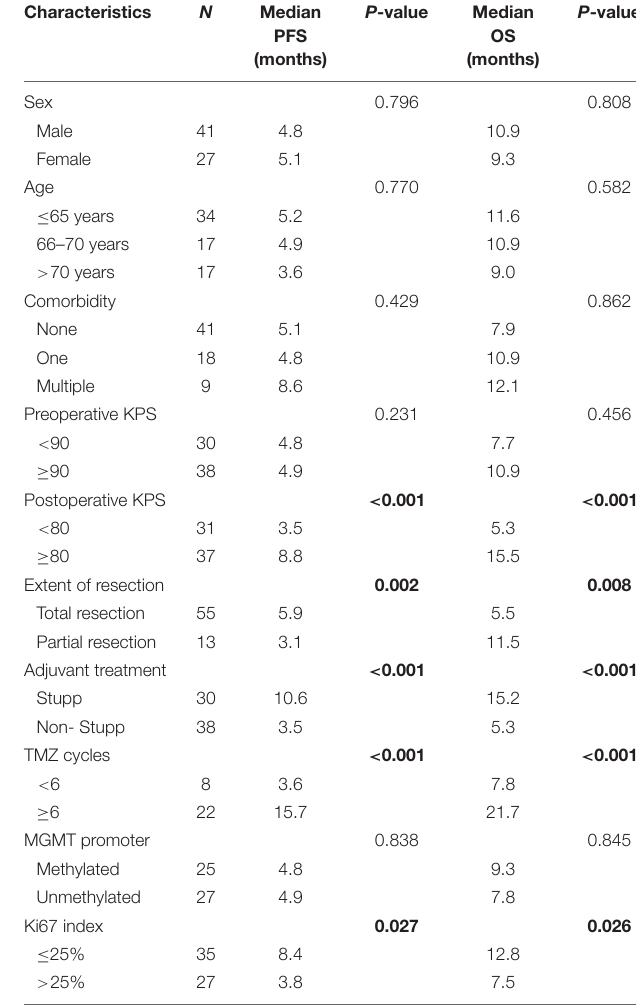
TABLE 2 | Significant parameters on PFS and OS (univariate